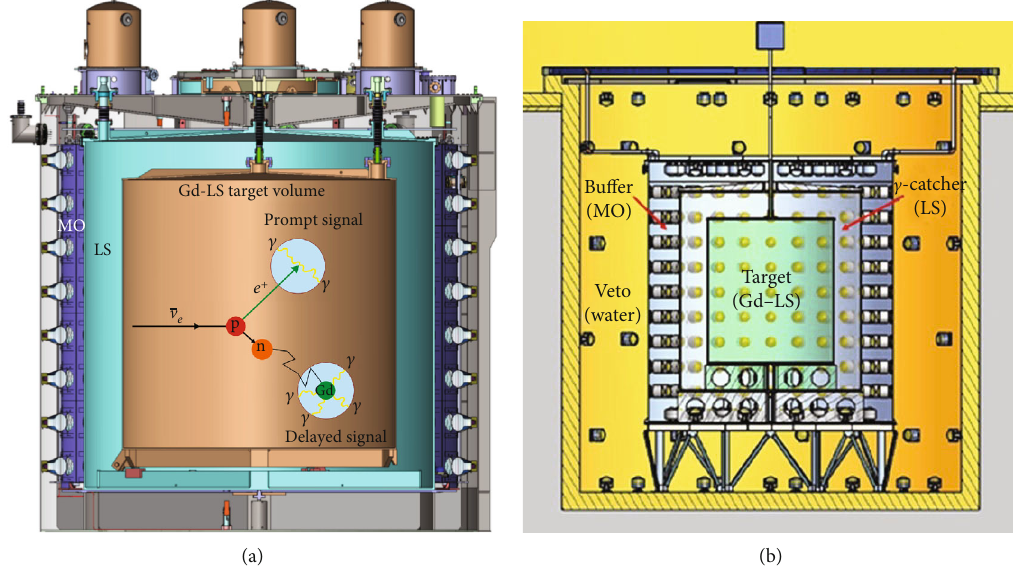
Figure 2: Schematic view of the Daya Bay ((a), adapted from [37]) and RENO ((b) [35]) antineutrino detectors, with the three concentric vessels (containing Gd-LS, LS, and MO) clearly identi fi ed. The interaction of a (cid:1) ν e with a proton in the target via IBD is shown inside the Daya Bay inner-most